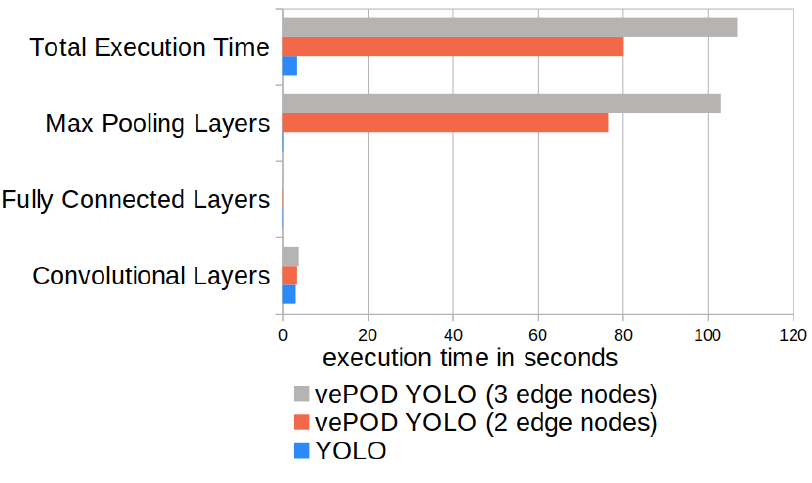
Figure 8. Performance comparison of YOLO and vePOD YOLO run on two and three edge